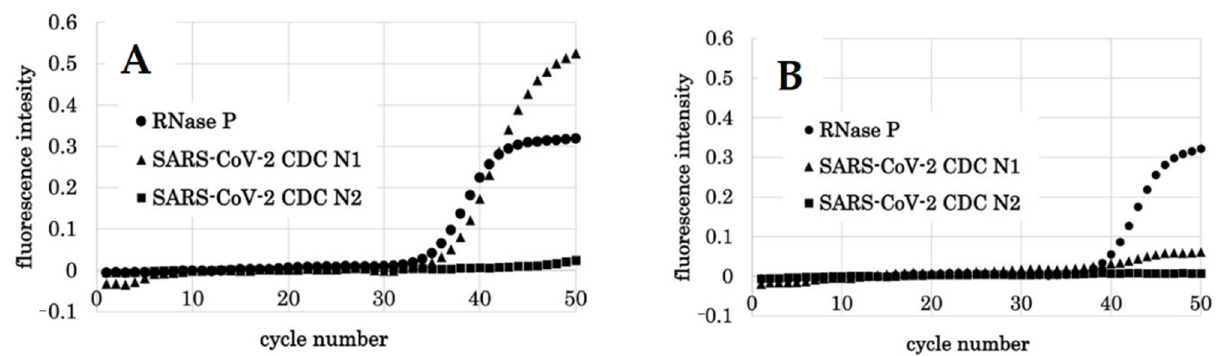
Figure 5. qPCR results by PCR1100 of subject 12. ( A ) Results of the first qPCR (8th day after the onset of symptoms). RNase P was detected with a Ct value of 34.4, indicating that there was no problem with the PCR reaction. CDC N1 increased at